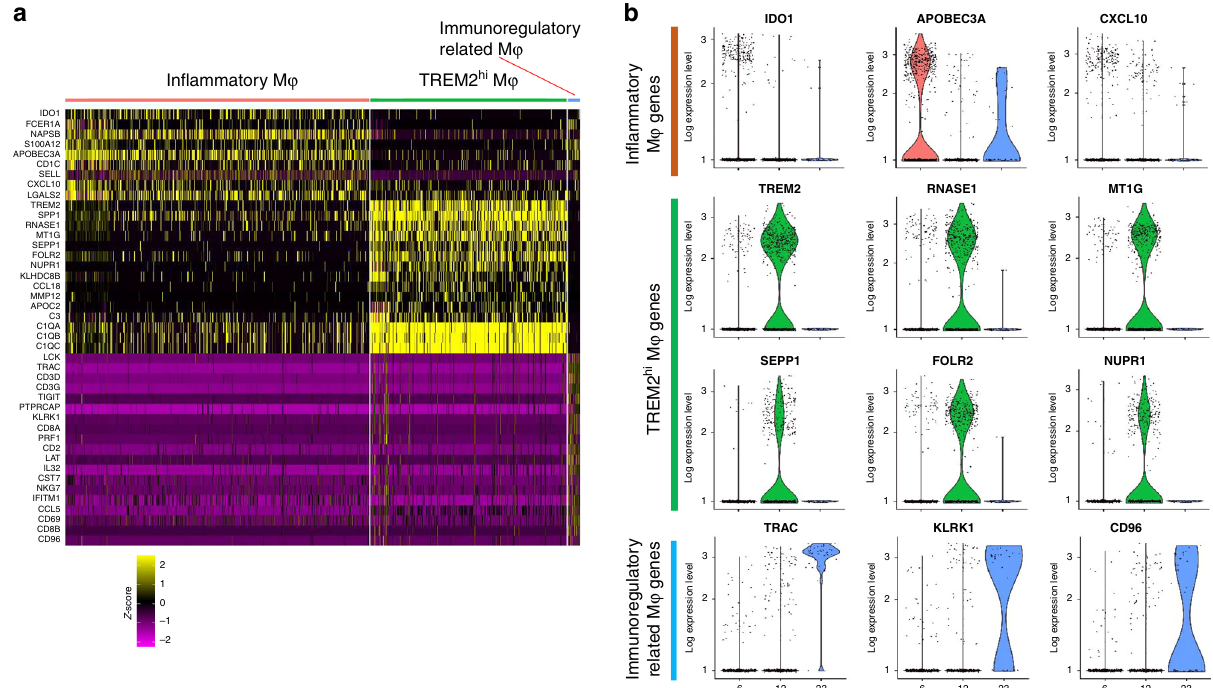
Fig. 2 Subsets of macrophages in the melanoma tumors. The scRNA-seq dataset - GSE120575 was used in this analysis. a Heatmap of z -scored expression of the top up-regulated genes of each macrophage subpopulation versus the other two macrophage subpopulations. b Violin plots of log- transformed gene expression of selected genes showing statistically signi fi cant upregulation in in fl ammatory macrophages (top), TREM2 hi macrophages (center), and Immunoregulatory related macrophages